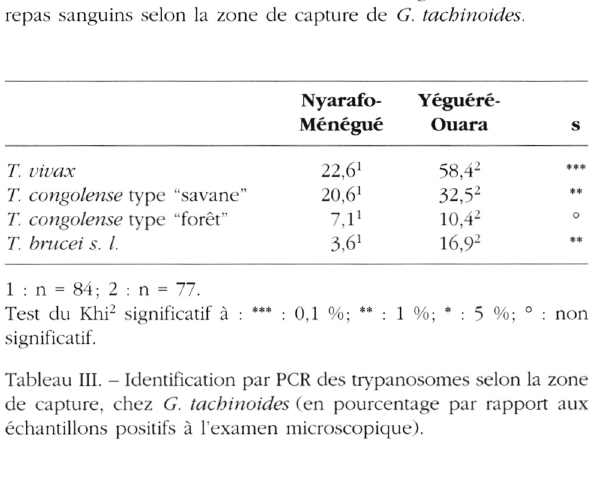
Tableau III. - Identification par PCR des trypanosomes selon la zone de capture, chez G. tachinoides (en pourcentage par rapport aux échantillons positifs à l’examen